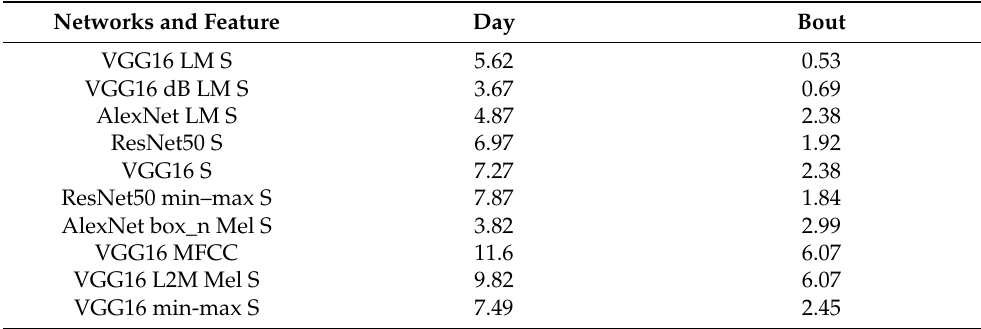
Table 4. Equal Error Rate (EER) of Best Performing Single Network on the EER Day and EER Bout Datasets (sorted by performance).